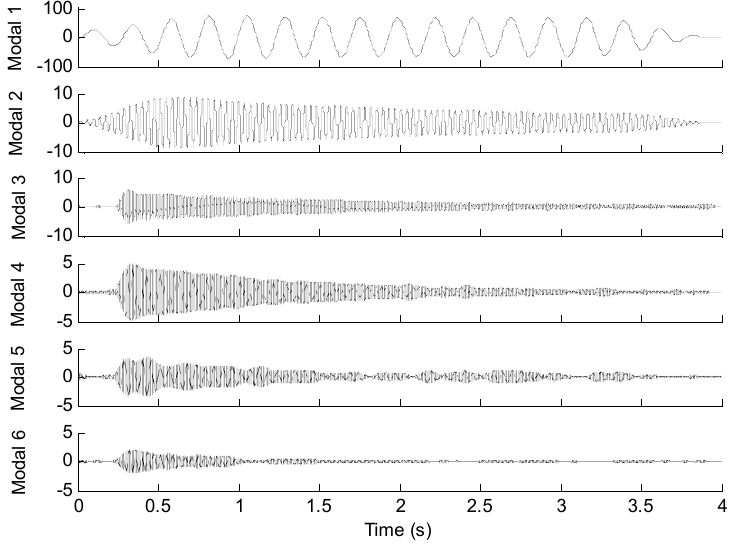
Figure 16. Modal responses of the 15-th optical fiber measurement data obtained by EMD method with intermittency criteria.